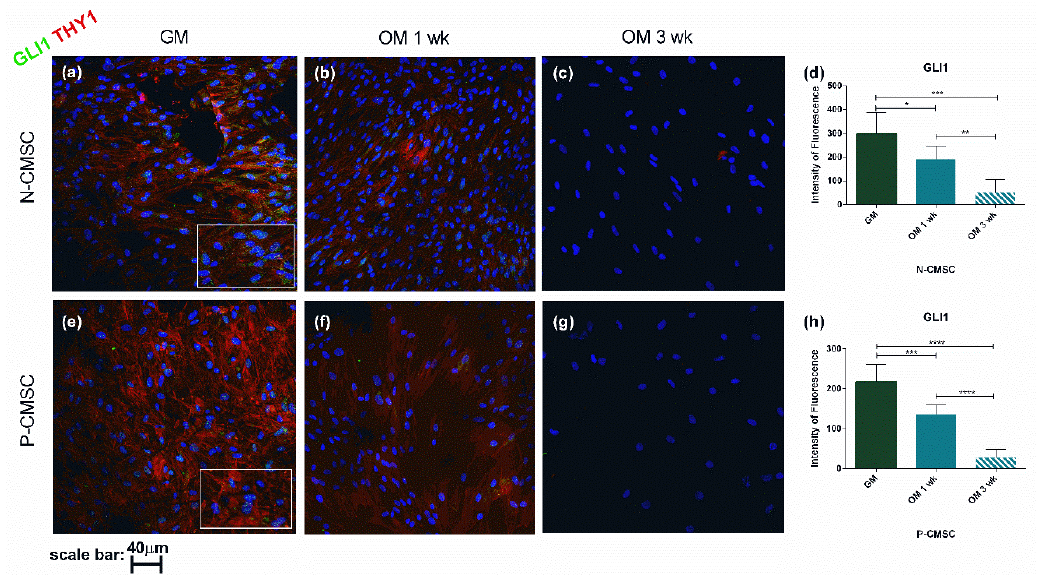
Figure 7. Expression of GLI1 and THY1 in CMSC during osteogenic induction. Markers’ expression analysed by immunofluorescence in ( a – c ) N-CMSC and ( e – g ) P-CMSC, cultured with osteogenic medium (OM) for one (1 wk) and three weeks (3 wk), compared to cells cultured in growth medium (GM). Nuclei are stained in blue with DAPI. The intensity of fluorescence was quantified by the ImageJ software for both ( d ) N-CMSC and ( h ) P-CMSC. * p < 0.05; ** p < 0.01; *** p < 0.001; **** p < 0.0001. Pictures are representative of 30 microscopic fields of three different cell culture samples (see Methods for details).